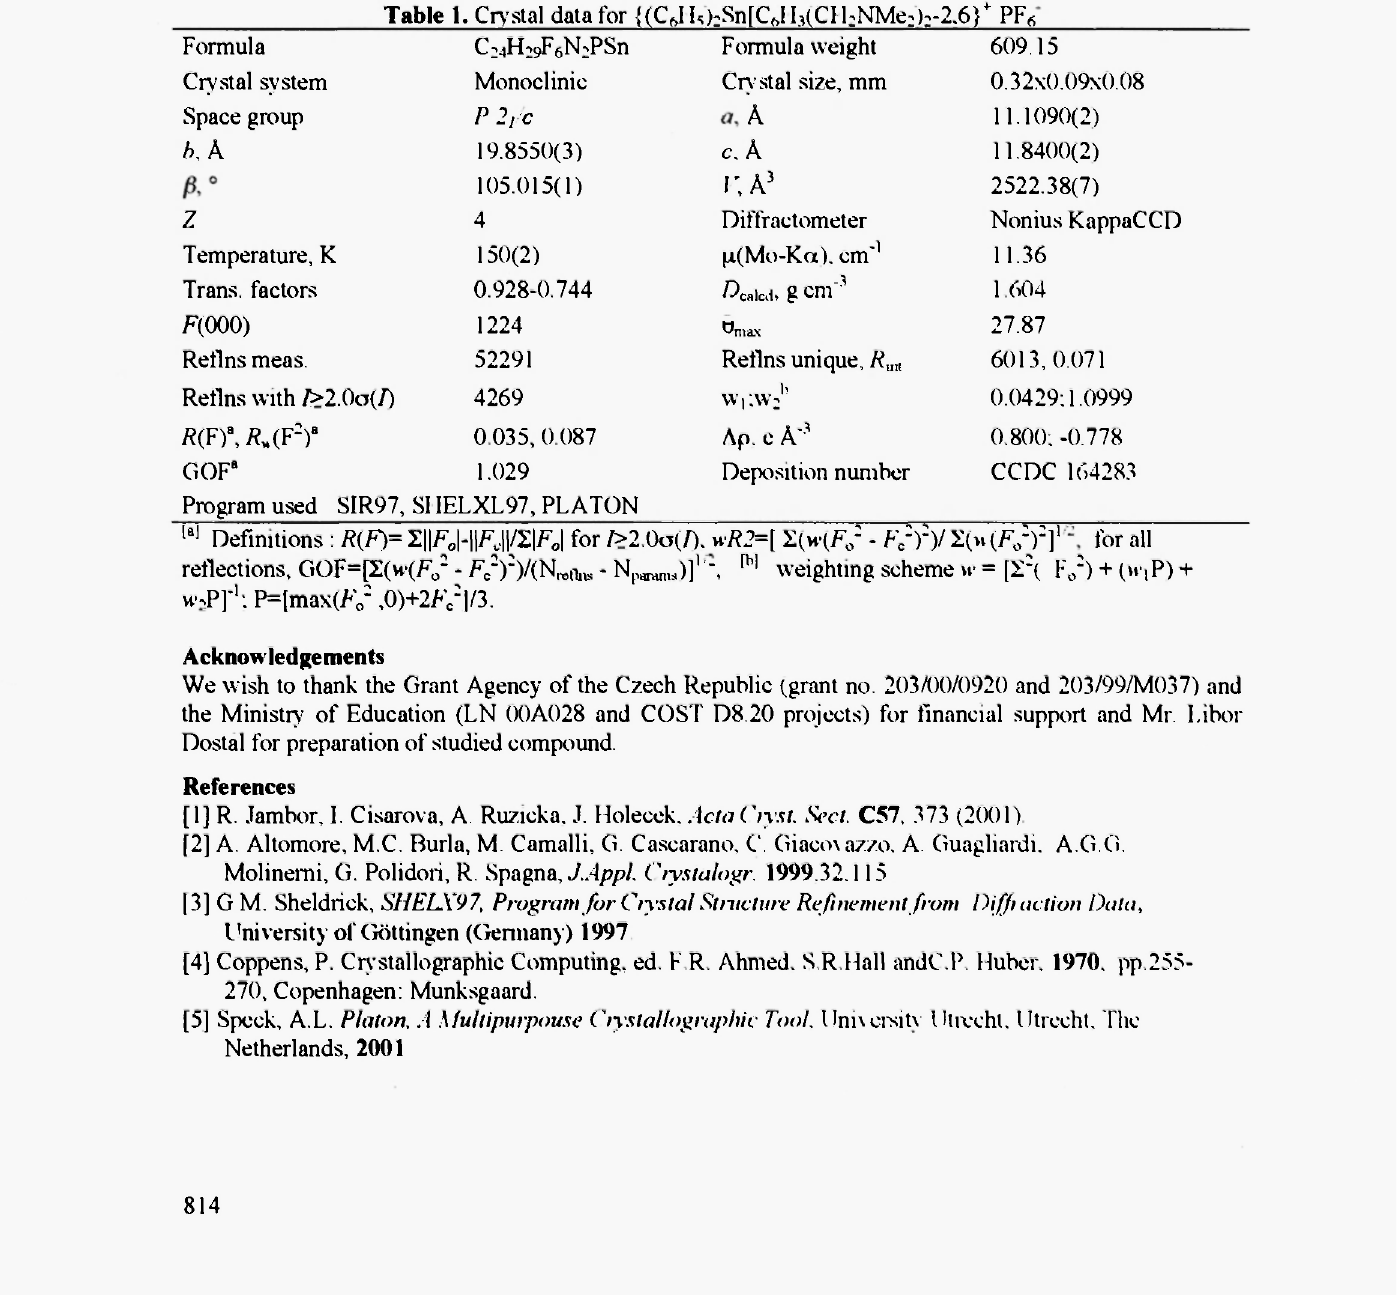
Table 1. Crystal data for {(C ft I Uh^nfC,,! I 3 (CT l : NMe : );-2.6}' PF